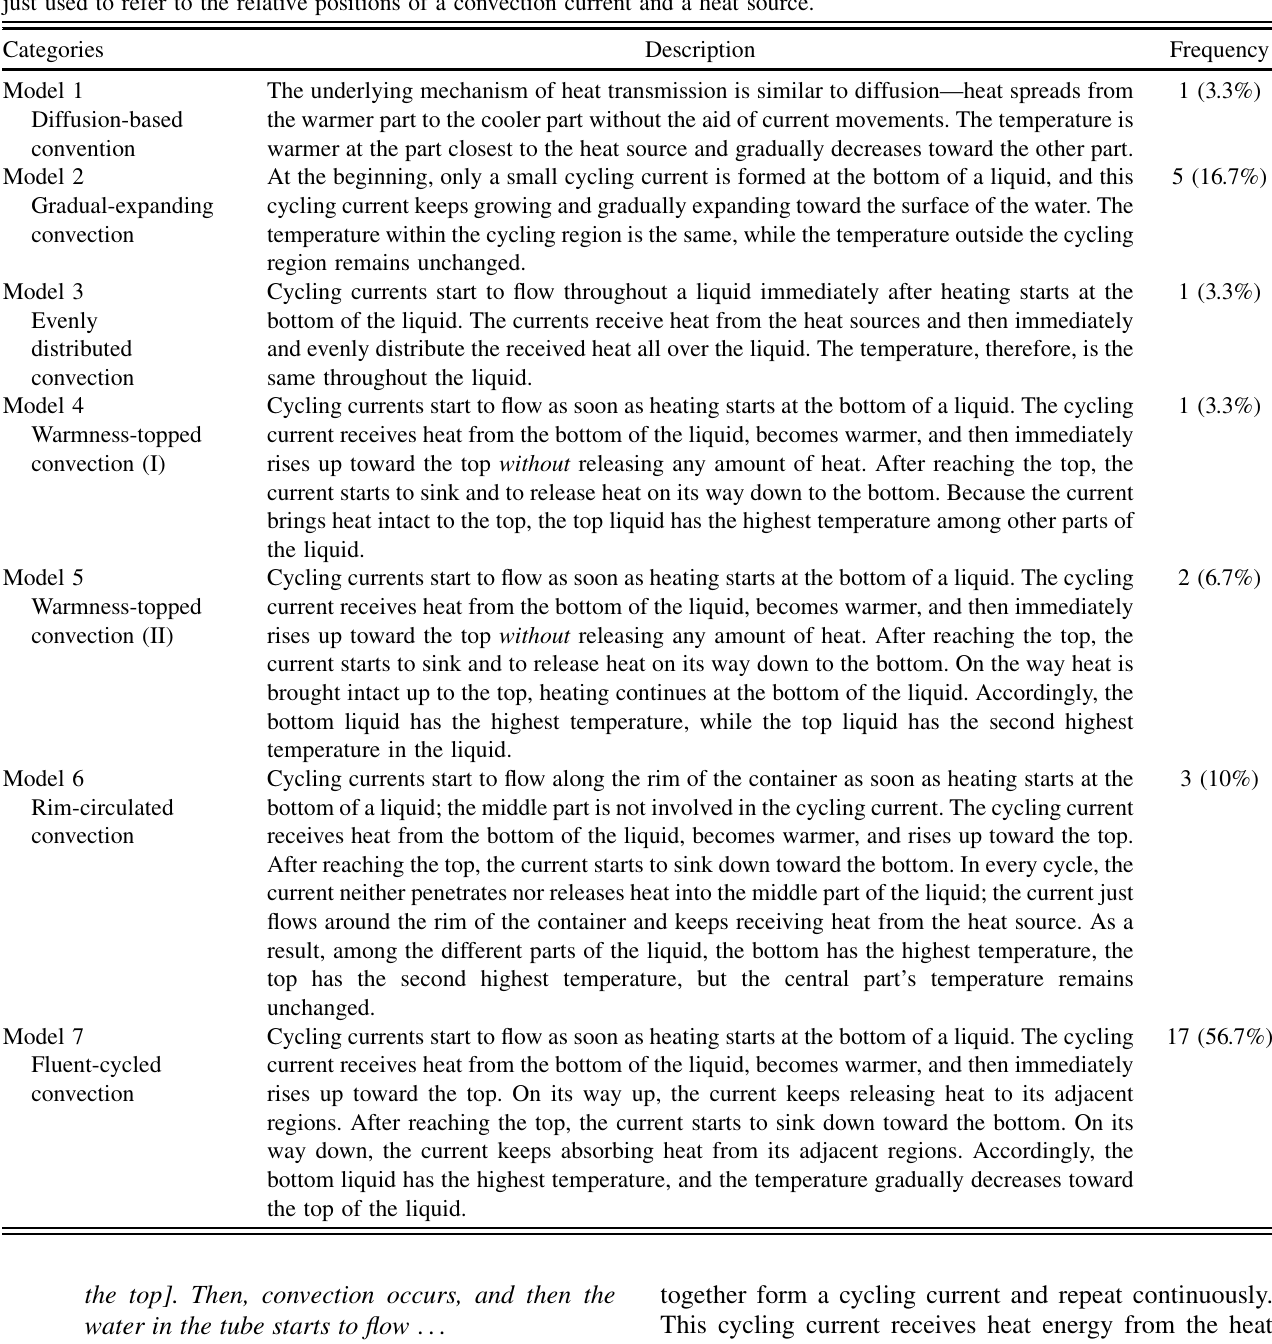
TABLE I. Patterns of the participants’ mental models of heat convection. Note that the ‘‘heat source’’ in this table can be generalized to any warmer substance within a liquid. In addition, this heat source need not be located below the liquid; ‘‘top’’ and ‘‘bottom’’ are just used to refer to the relative positions of a convection current and a heat